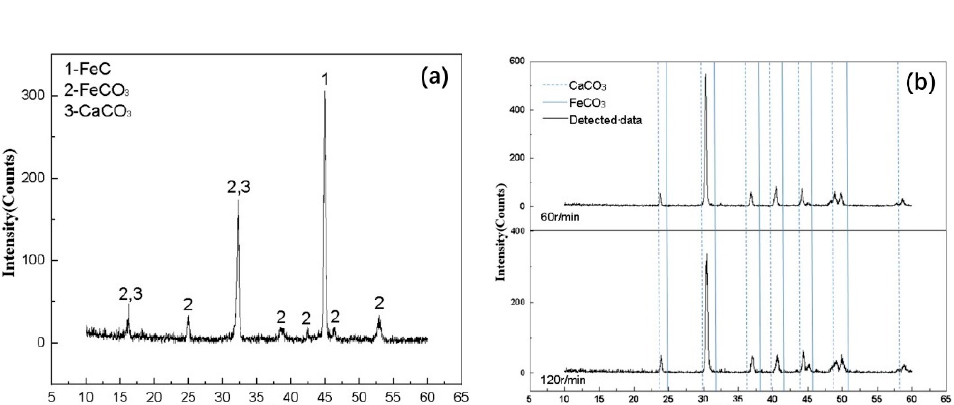
Figure 4. Microstructures of the corrosion products at 0 r/min ( a ), 60 r/min ( b ), 120 r/min ( c ), and 180 r/min ( d ), respectively.